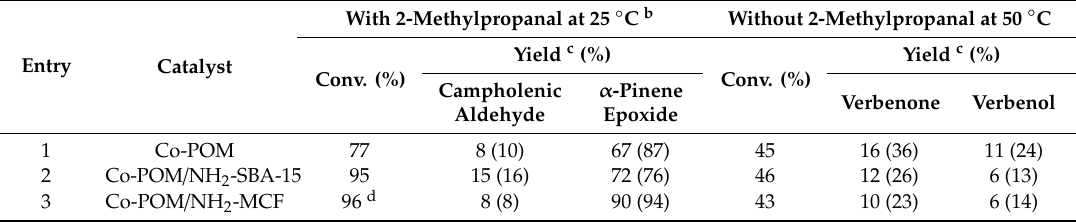
consumed). d After 2